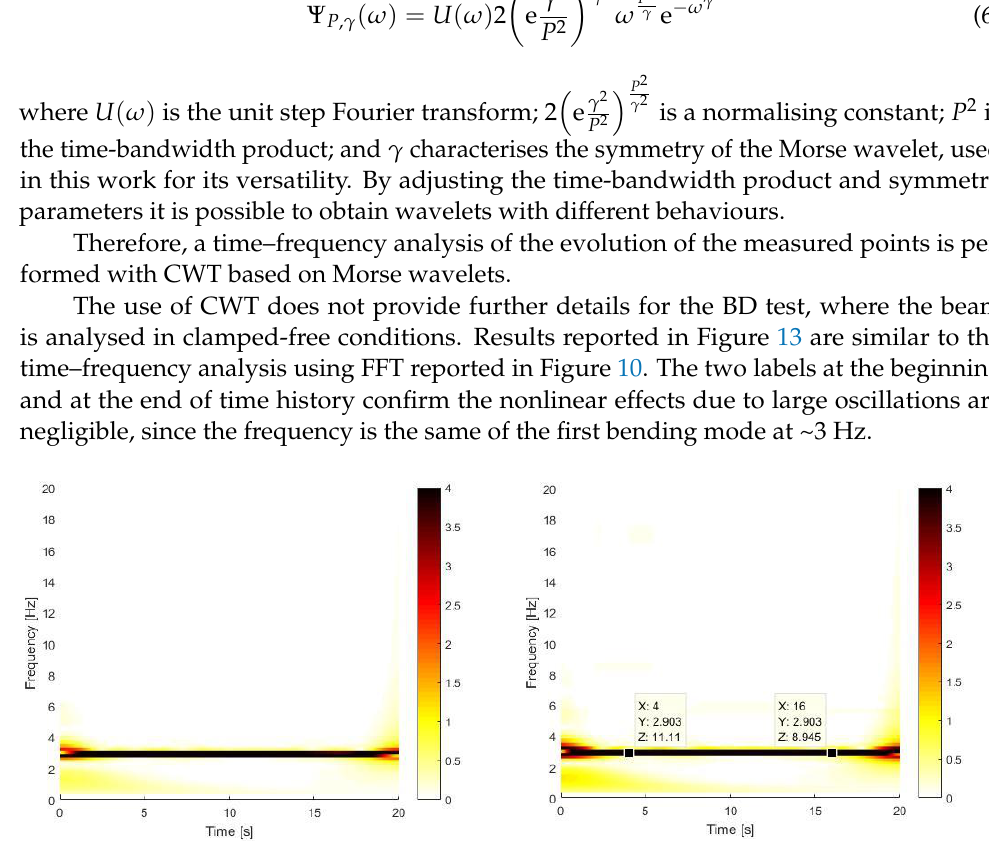
( b ) Figure 14. Time – frequency contents of MaD test using CWT method for P11 (magnets) ( a ) and P14 (mass) ( b ) profilometer points. The application of the CWT method to the CD test returns the most interesting re- sults, as shown in Figure 15. From a global point of view, several high spectral contents can be noticed at different frequencies. The markers in Figure 15a, which represent the time – frequency analysis for the contact point, show a frequency contribution at ~86 Hz